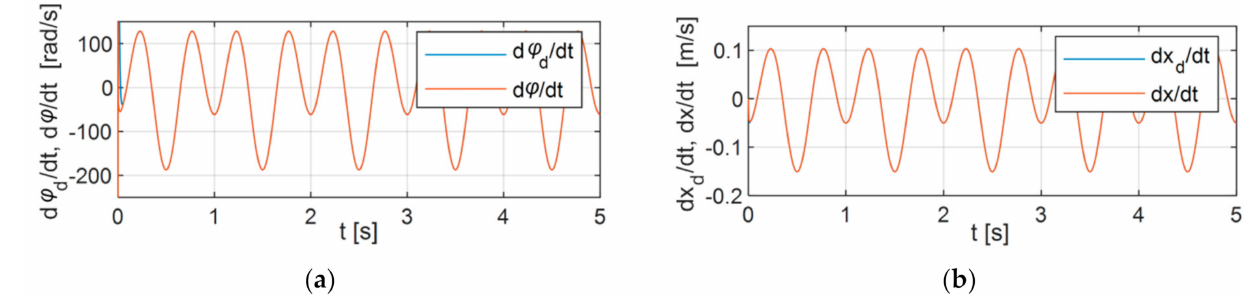
Figure 9. Trajectory: ( a ) adjusted d ϕ d / dt and realized d ϕ / dt speeds of the active part; ( b ) adjusted dx d / dt and realized dx / dt speeds of the passive part.